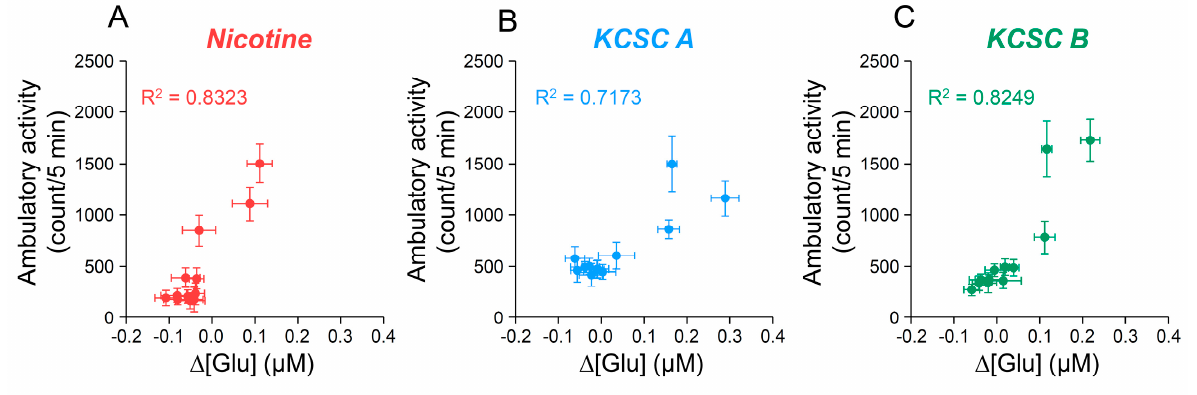
Figure 6. Correlation coefficients for the relationships between the rate of change in glutamate concentration ( Δ [Glu]) of the dorsal striatum and psychomotor behaviors after 14 days of repeated administration of two KCSCs. 4. Discussion Tobacco plants and products, such as cigarettes and chewing tobacco, contain a psy- choactive compound, nicotine as well as non-nicotine alkaloids, such as nornicotine, co- tinine, anabasine, anatabine, and etc. [10–13]. Previous studies demonstrated that the con- tent and ratio of nicotine and non-nicotine alkaloids in cigarette products differ signifi- cantly from brand to brand, but in general, most cigarette products consist of high amount of nicotine (more than 90%) and also contain non-nicotine alkaloids including nornicoitne, anatabine, and anabasine [12,13]. Consistently, results from this study demonstrated that KCSC A and KCSC B included more than 95% of nicotine as well as non-nicotine alka- loids, such as nornicotine (KCSC A: 0.49%, KCSC B: 0.47%), cotinine (KCSC A: 0.12%, KCSC B: 0.15%), anatabine (KCSC A: 3.40%, KCSC B: 3.46%), anabasine (KCSC A: 0.10%, KCSC B: 0.08%), myosmine (KCSC A: 0.02%, KCSC B: 0.02%), norharmane (KCSC A: 0.01%, KCSC B: 0.01%), and harmane (KCSC A: 0.01%, KCSC B: 0.01%). Taken together, these findings suggest that the two different commercial cigarette products in South Korea also contained psychoactive components, such as nicotine and non-nicotine alkaloids like other cigarette products.